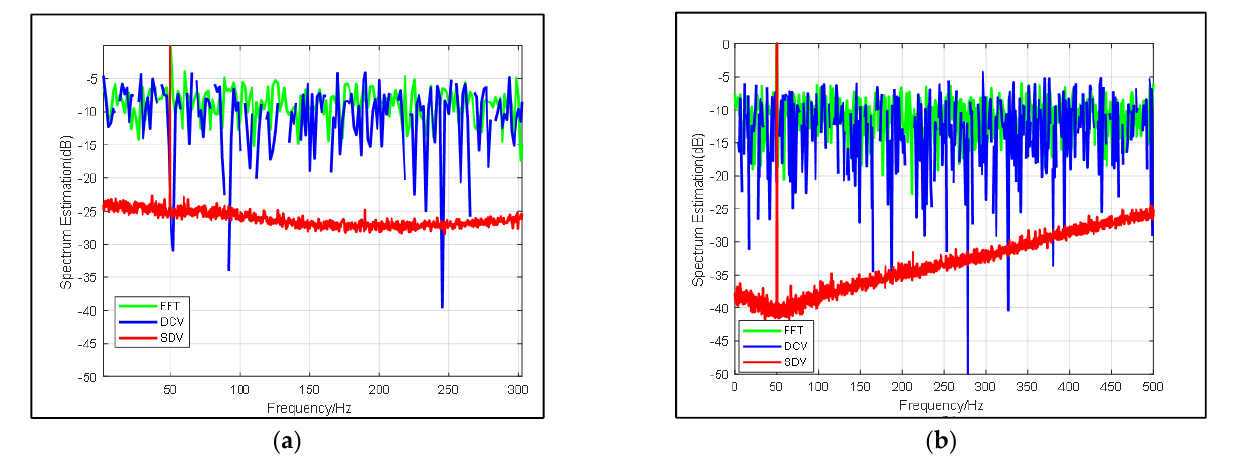
Figure 3. Comparison of frequency spectrum estimation results from FFT (blue line), DCV (green line) and SDV (red line) with same input SNR = − 15 dB and different snapshots: ( a ) snapshots = 3000 and ( b ) snapshots = 5000.